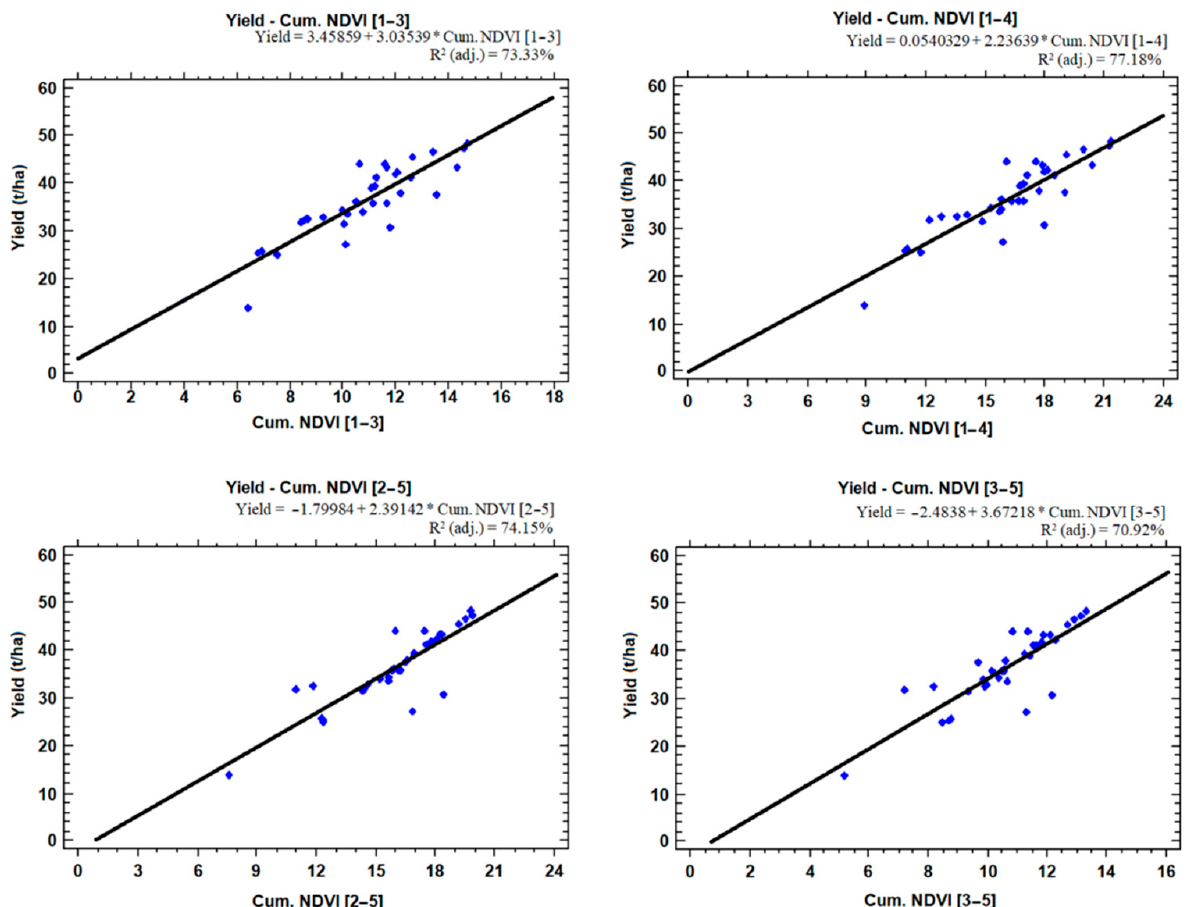
Figure 9. The linear regression models that describe the relationship between the different selective cumulative NDVI range values and the corresponding recorded yield across all pilot fields.